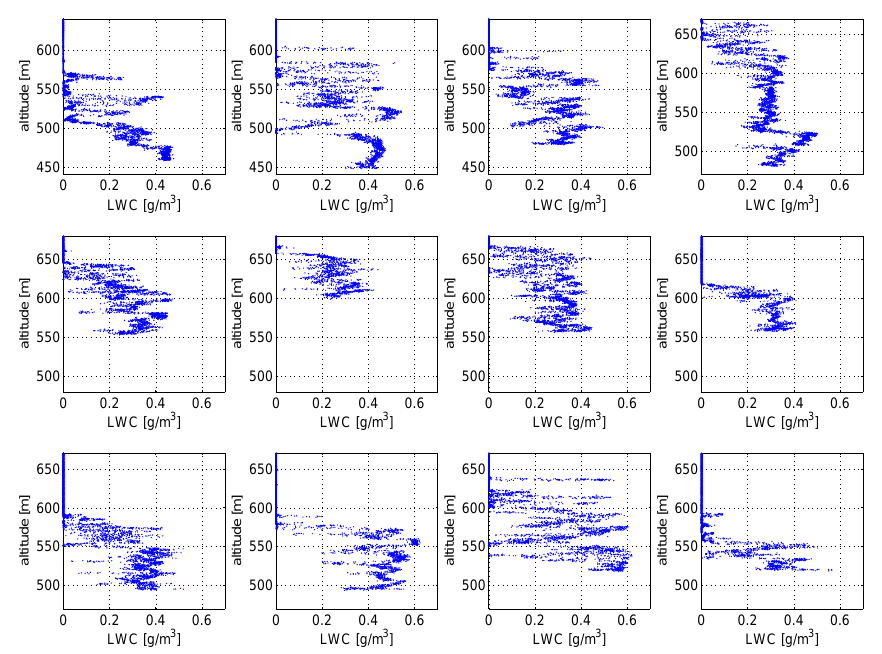
Fig. 9. As in Fig. 8 but for flight